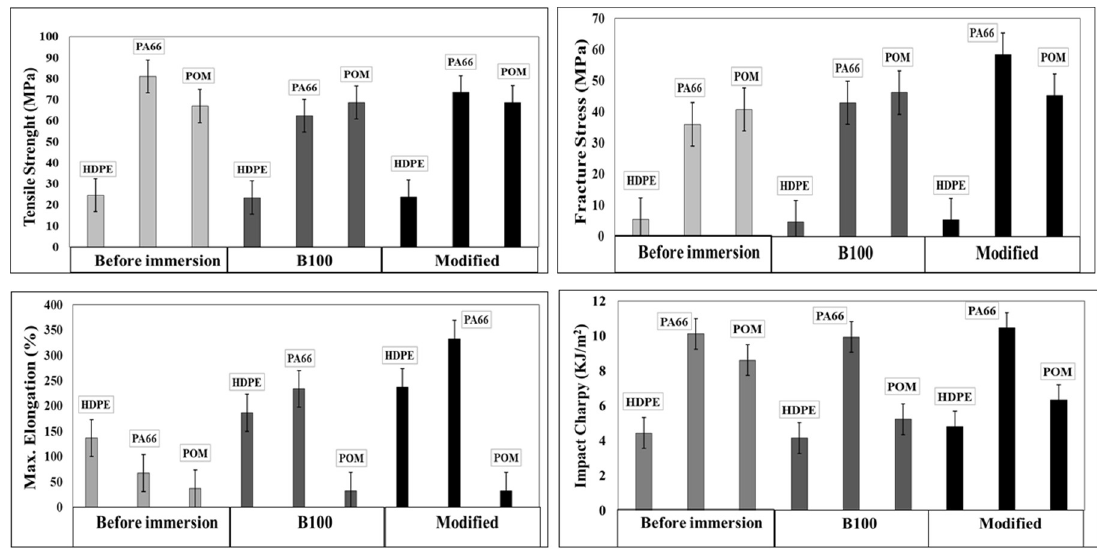
Figure 13. Evaluation of tensile strength, fracture stress, maximum elongation, and Charpy impact of HDPE, PA66, and POM before and after immersion in B100 and B100–fatty acid blend (modified: 0.32% palmitic + 0.32% oleic acids).